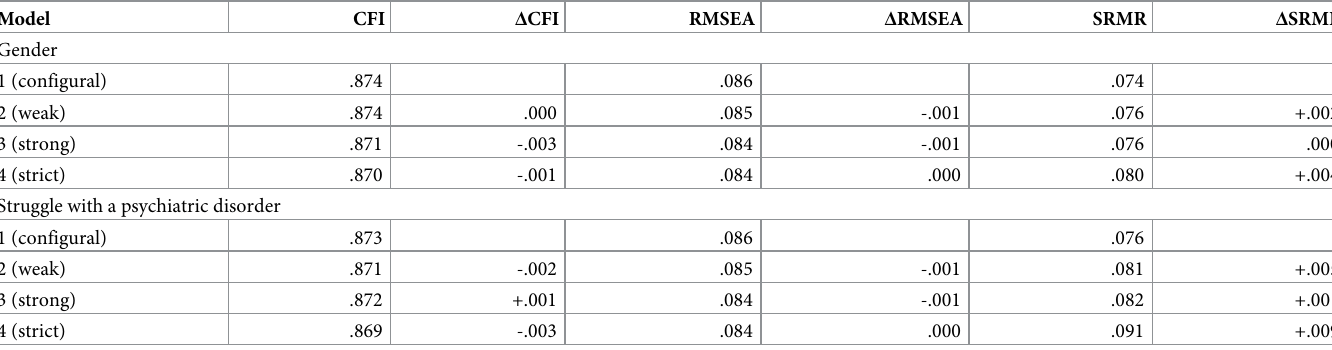
CFI, comparative fit index; RMSEA, root mean square error of approximation; SRMR, standardized root mean square residual. Critical values for the rejection of the null hypothesis of factorial invariance at any level are decrease in CFI > .010, increase in RMSEA > .015, and increase in SRMR > .010 [33]. No changes in model fit indices exceeded these values.